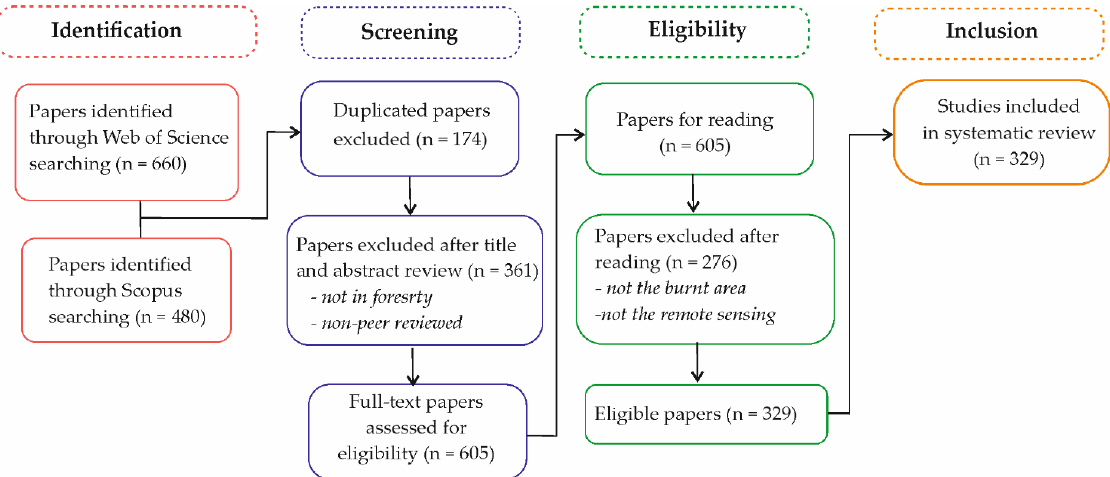
Figure 1. The schematic diagram of the papers selection order from 2000 to 2020 in the field of remote sensing of forest BA, BS, and post-fire recovery in the Preferred Reporting Items for Systematic Reviews and Meta-Analysis (PRISMA) framework.